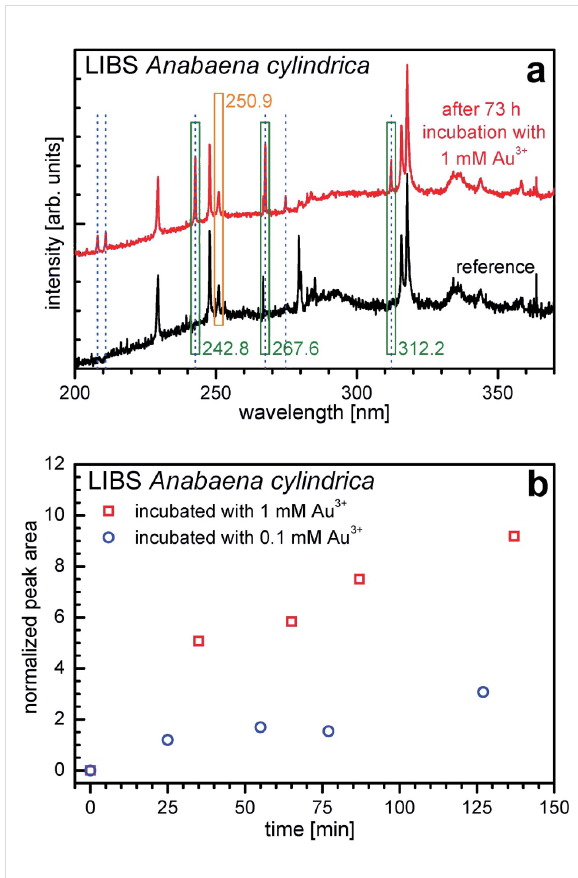
Figure 6: (a) LIBS spectra of dried biomass of Anabaena cylindrica (reference, black) and after incubation for 73 hours with an overall con- centration of 1 mM Au 3+ (red). Dotted blue lines indicate positions of characteristic peaks of gold. The green boxes show the peaks origi- nating from gold and the orange box the peak originating from ambient air. The first ones are used as a measure of accumulated amount of gold, the second as an internal reference for the semi-quantitative analysis. (b) Amount of gold recorded in dried unwashed biomass of Anabaena cylindrica incubated with an overall concentration of 1 mM (red open squares) resp. 0.1 mM (blue open circles) Au 3+ over time. This amount of gold is retrieved from the averaged area of the gold in- dicating peaks (242.8 nm, 267.6 nm, 312.2 nm) divided by the area of one peak from ambient air (250.9